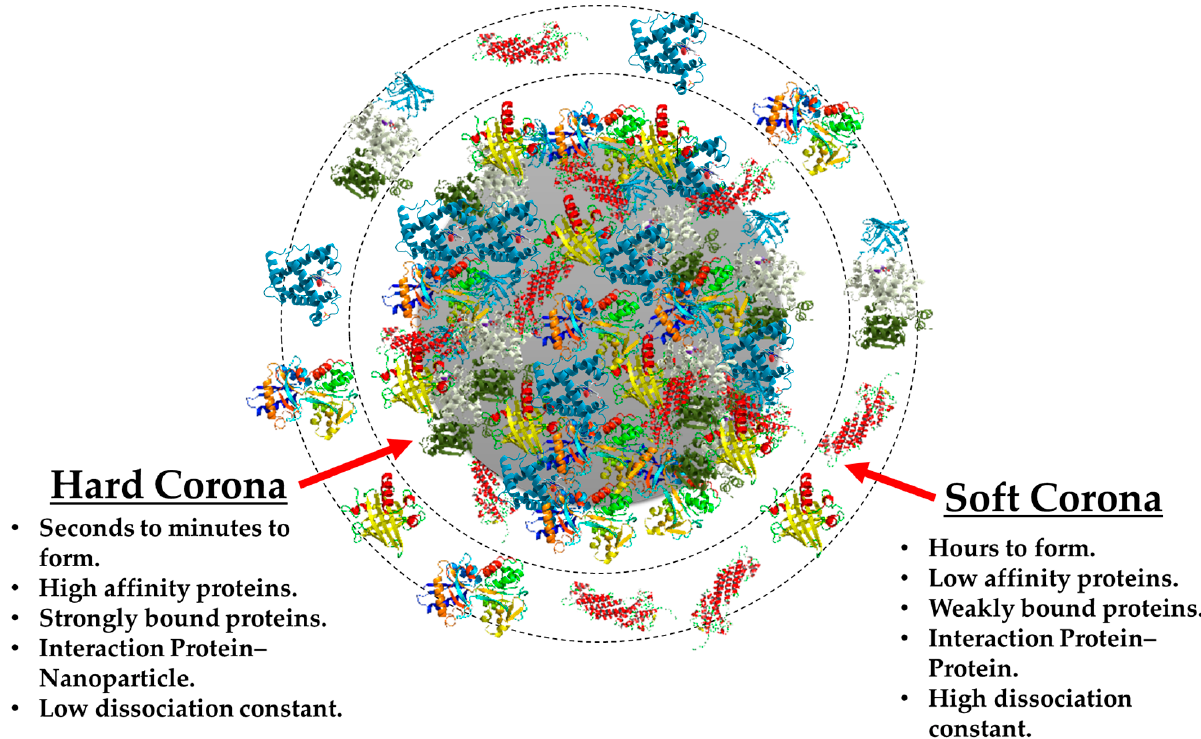
Figure 5. Schematic comparison of the main differences between the “hard” corona and the “soft” corona.